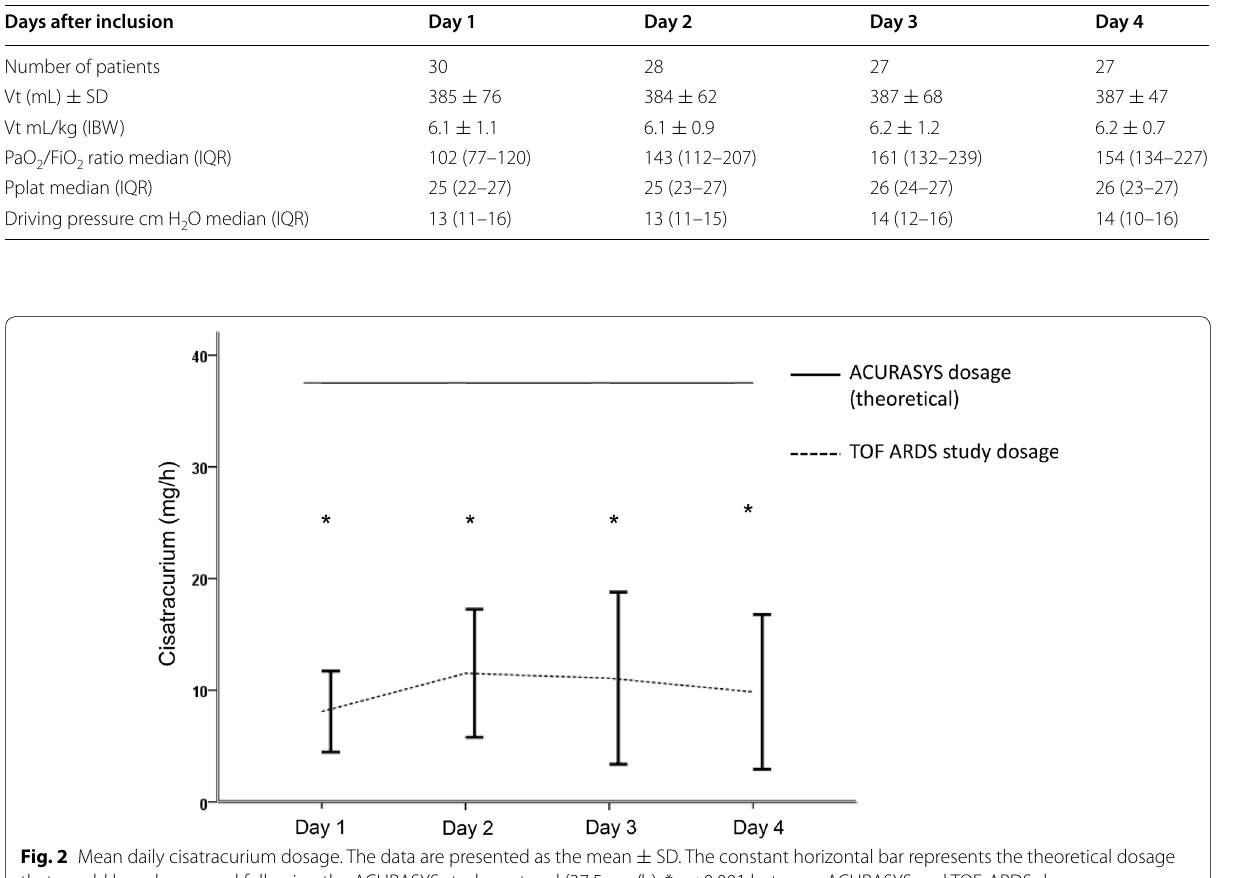
SD. The constant horizontal bar represents the theoretical dosage ±